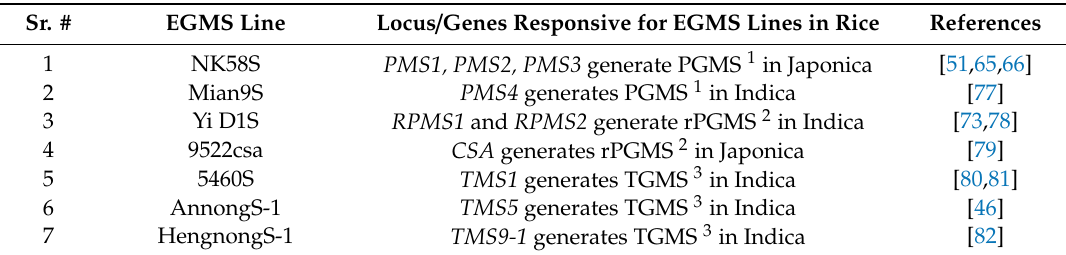
Table 2. The prominent characters of the key EGMS lines and regulating factor / gene. Sr.